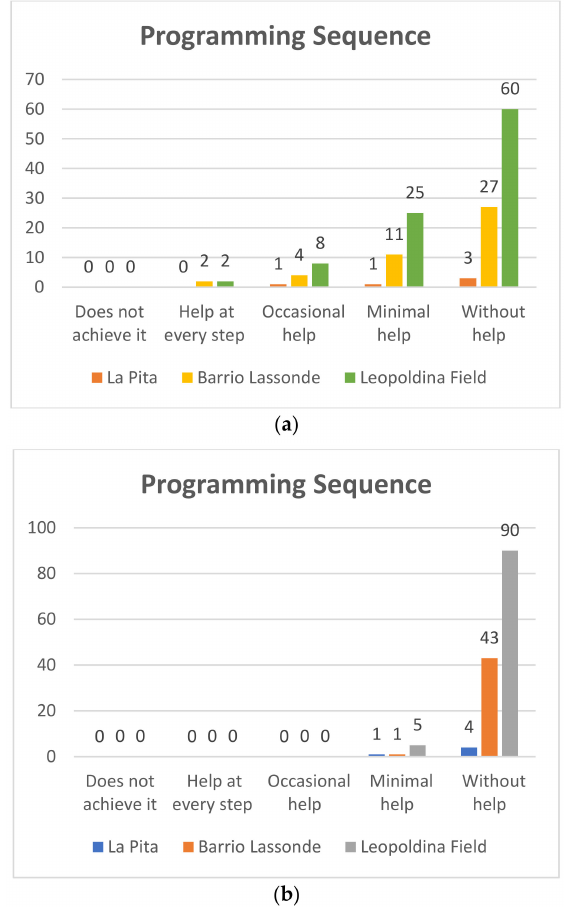
Figure 10. First grade programming sequence Pre-Test ( a ) and Post-Test ( b